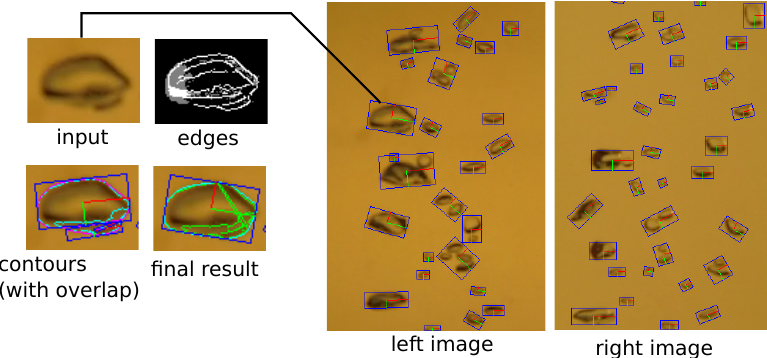
Figure 8. Detected bubbles in image ROIs. In cyan : contour around the bubble rim. In blue : rectangles describing the